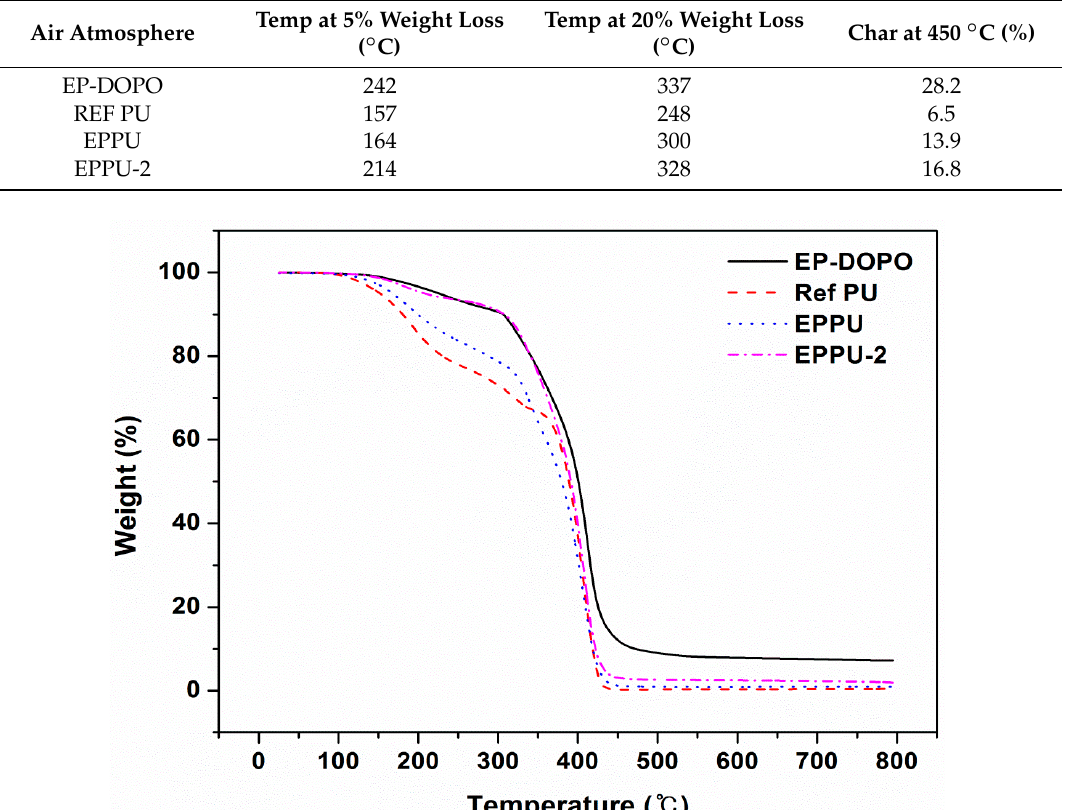
Figure 6. Thermogravimetric analysis (TGA) data for Ref PU and EPPU in N 2 DOPO: